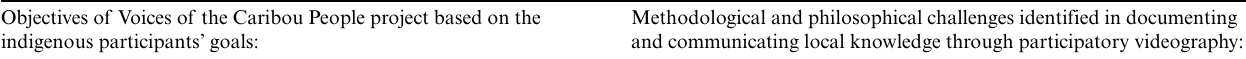
Table 1 . Participant-defined goals and literature-based challenges for accomplishing those goals. Our criteria for evaluation of Voices of the Caribou People Project were how successfully we (1) overcame the challenges and (2) accomplished community goals. Objectives of Voices of the Caribou People project based on the Methodological and philosophical challenges identified in documenting indigenous participants’ goals: and communicating local knowledge through participatory videography: Document the Caribou People’s local knowledge and observations about the changes taking place in their Human- Rangifer Systems to create a repository of knowledge for the communities and their future